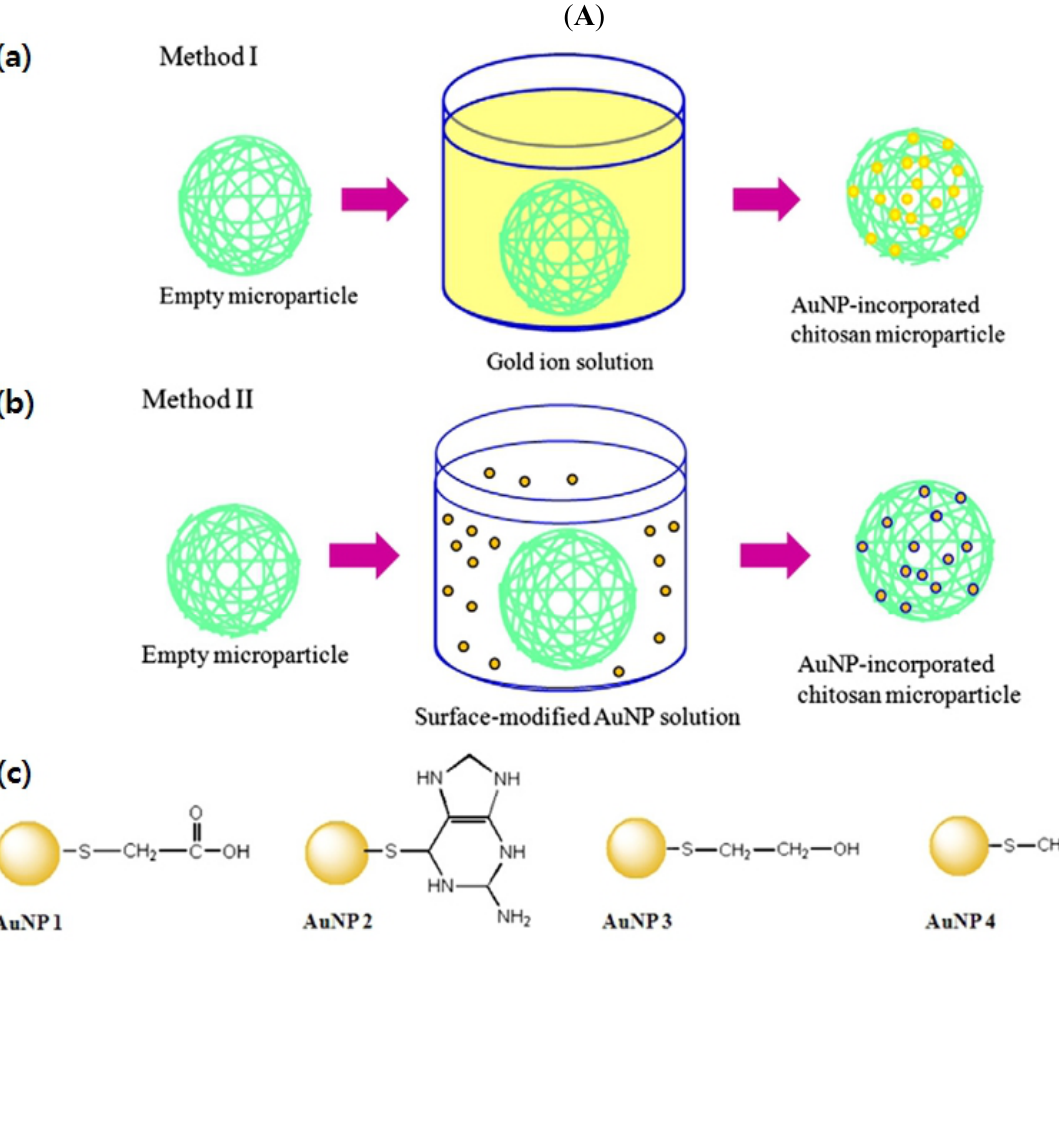
Figure 6. ( A ) AuNP incorporation into chitosan microparticles. ( a ) The Au ions are reduced in the empty microparticles (Method I). ( b ) Surface-modified AuNPs diffuse into the empty microparticles (Method II). ( c ) Surface-modified AuNPs used in Method II [83]. ( B ) ( a ) X-ray images of the dried microparticles fabricated by Method I (Figure 5B) with 6.35 × 10 − 2 mmol Au ions. The size of the microparticles increases according to the molecular weight of chitosan: #1 (20,000 Da), #2 (30,000 Da) and #3 (85,000 Da). ( b ) X-ray images of the microparticles containing reduced AuNPs. AuNPs are reduced in the chitosan microparticles (20,000 Da) at 6.35 × 10 − 3 [I], 3.15 × 10 − 2 [II], and 6.35 × 10 − 2 [III] mmol Au [60]. (C ) A typical raw ( a ), averaged ( b ), and preprocessed ( c ) X-ray image of the blood flow in a rat cranial vena cava. ( d ) The velocity vectors obtained from the rat vein. The dotted line represents the velocity profile of the blood flows as suggested by Casson model. The solid line denotes the parabolic curve fitting on the experimental data. R is ave the vessel radius averaged from X-ray images [6]. Adapted by permission from Springer. ( A